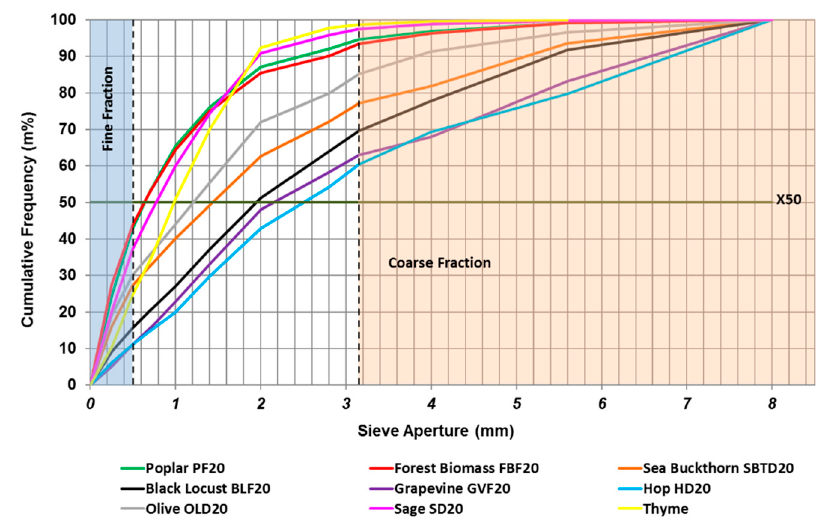
Figure 5. Particle size distribution of fibre produced by the extruder at ATB at identical aperture setting (20 mm).